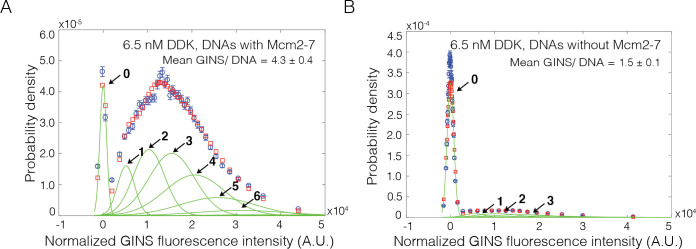
Mcm2-72SORT549 dependence of GINSSORT649 binding.GINSSORT649 fluorescence-intensity histograms (blue) from the same recording on (A) Mcm2-72SORT549-bound DNA (same data as Figure 5Cii) and (B) DNA molecules without bound Mcm2-72SORT549. The histogram data were fit to a sum-of-Gaussians model (red; see Materials and methods). Fit parameters and calculated area fractions of individual Gaussian components (green) corresponding to the presence of the indicated numbers of GINSSORT649 molecules are given in Supplementary file 1b. The mean (± SE) numbers of GINS molecules per DNA calculated from the fit parameters and the fraction GINS labeled are indicated. Data in (B) may overestimate the amount of Mcm2-7-independent GINS binding because of the possible presence of a subpopulation of unlabeled Mcm2-7.